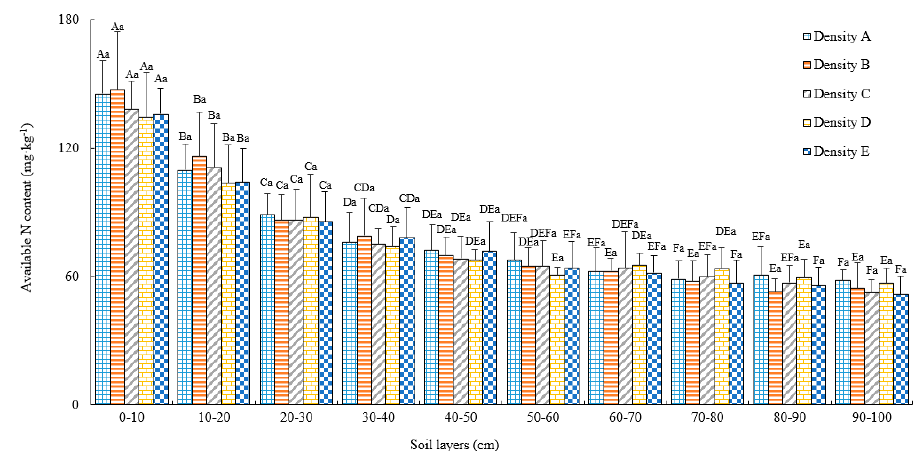
Figure 4. Soil alkali-hydrolyzable N in different layers under different stand densities (mg·kg − 1 ). Note: different lowercase letters indicate significant differences among different densities at the 0.05 level, and different capital letters for the same density indicate significant differences among different soil layers at the 0.05 level.